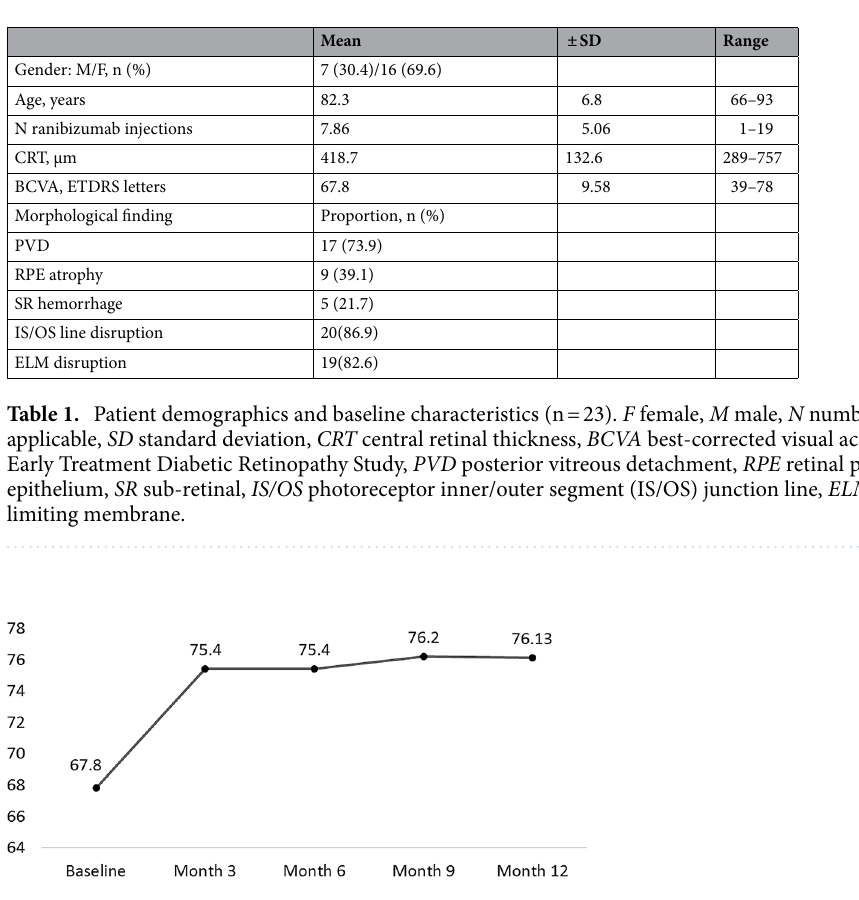
Figure 1. Mean BCVA (ETDRS Letters) during 12 months